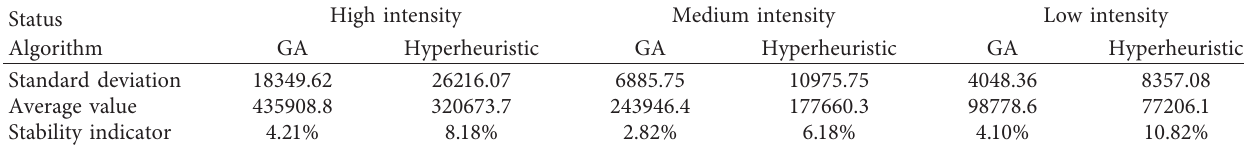
Table 4: Stability analysis table of GA and hyperheuristic algorithm under increasing passenger flow.